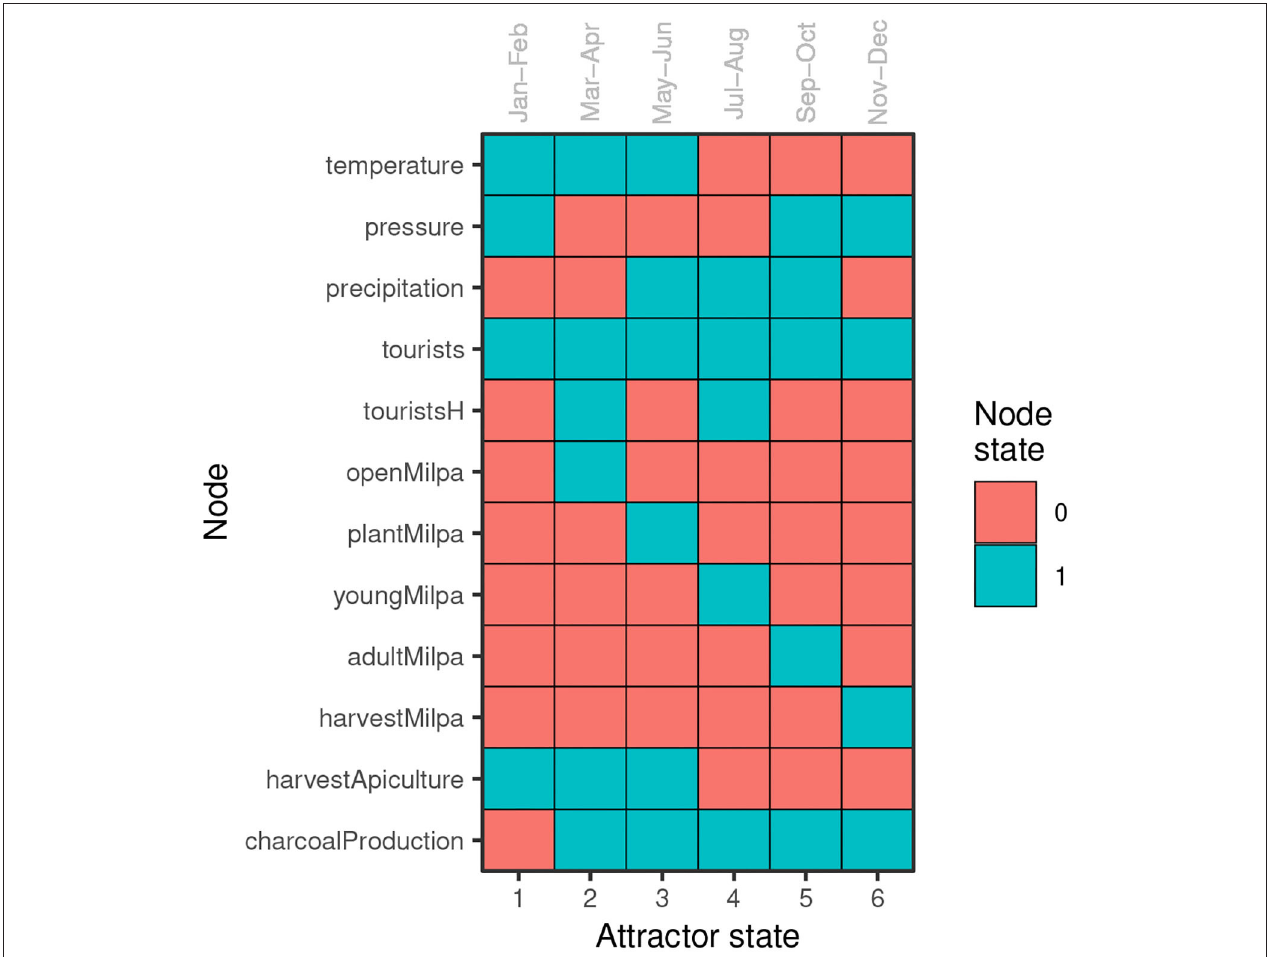
FIGURE 3 | Attractor recovered by the submodels built with boolean network modeling. Rows represent each node of the network, columns are the attractor states and each color represents a different state of the node (0, inactive; 1, active). Each of the attractor states of this cyclic attractor of period six can be interpreted as a snapshot of the approximate state of the SES in a given bimester (see subsection Submodels Built With Boolean Network